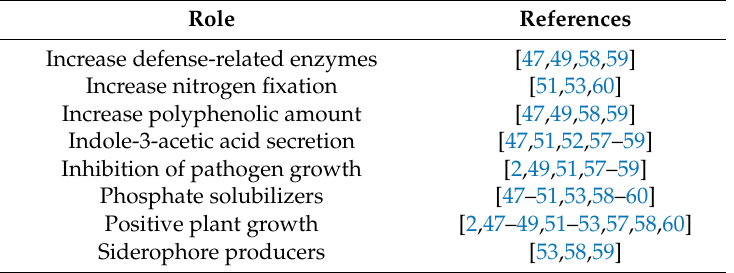
Table 1. Roles of endophytic bacteria from Camellia sinensis